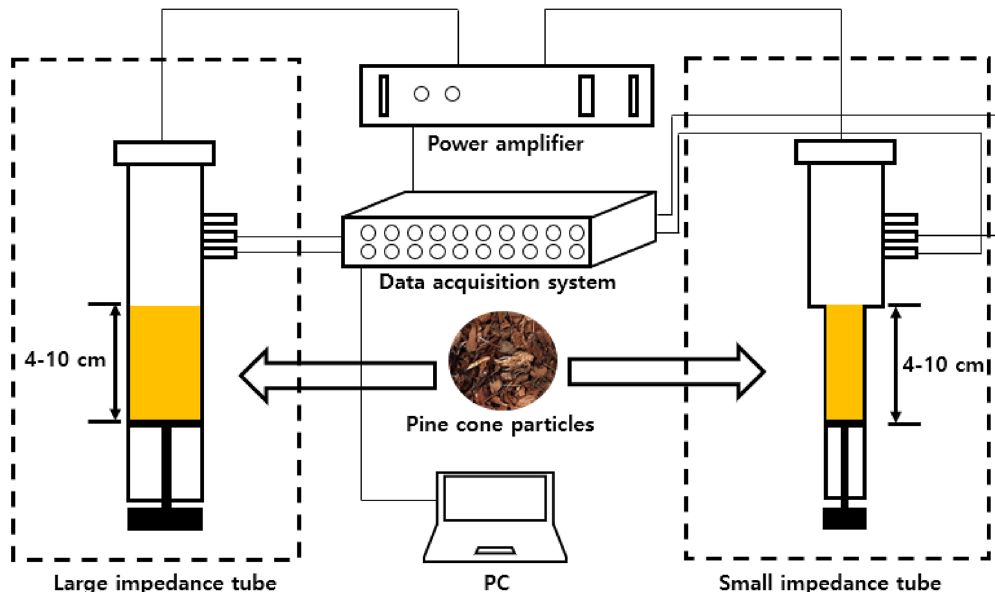
Fig. 2 Schematic of large and small impedance tubes for sound absorption coefficient